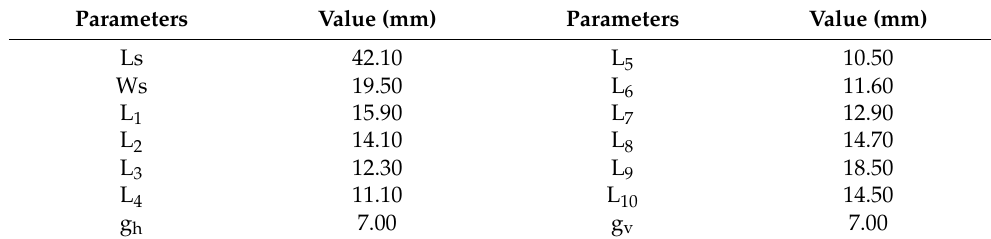
Table 1. Optimized tag dimensions.